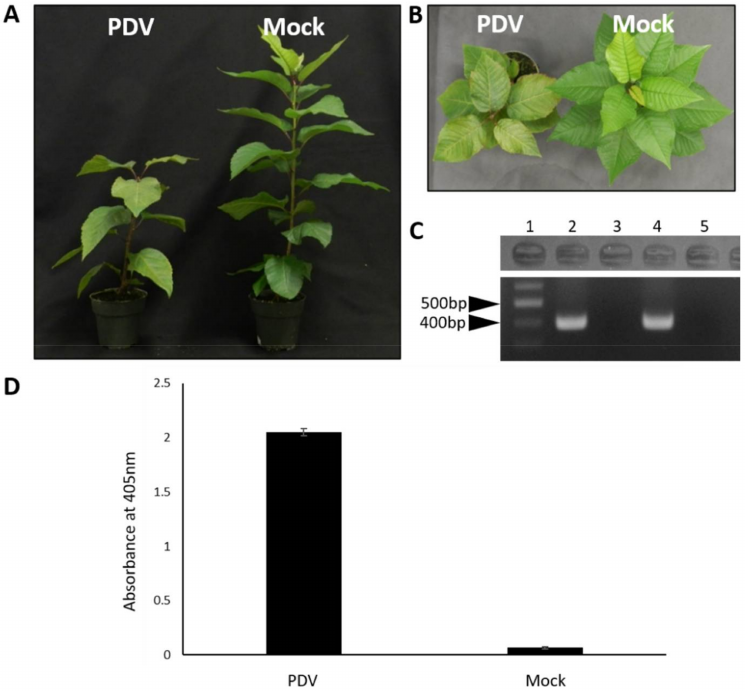
Figure 3. The PDV infectious clone is infectious on its natural host sweet cherry. Seedlings of cherry were agroinfiltrated with the PDV infectious clone to test the infectivity of this construct on the natural host. ( A ) Side view of seedlings infiltrated with the PDV infectious clone and empty vector (mock). Seedlings infected by PDV (left) have shorter internodal lengths resulting in a dwarfed or stunted phenotype compared to mock treated plants (right). ( B ) Aerial view of seedlings infiltrated with the PDV infectious clone or empty vector (mock). PDV infected seedlings (left) produce fewer leaves compared to mock treated plants (right). ( C ) The presence of PDV in upper non-infiltrated leaves of dwarfed cherry plants (left) was detected by RT-PCR. Lane 1: 1000 bp DNA ladder; 2: non infiltrated distal leaf of PDV infected cherry seedling at 8 wpa; 3: distal leaf of mock treated plant at 8 wpa; 4: a sample of foliar tissue known to be infected with PDV served as a positive control; 5: water was used as a negative control to test PCR reactions. ( D ) DAS-ELISA confirmed the presence of PDV in the distal, non-infiltrated leaf samples of the seedlings agroinfiltrated with the PDV infectious clone. The absence of PDV was confirmed in mock treated plants. The error bars represent the standard deviation of the means ( n = 5). This experiment was performed twice, and each experiment consisted of 5 seedlings receiving each